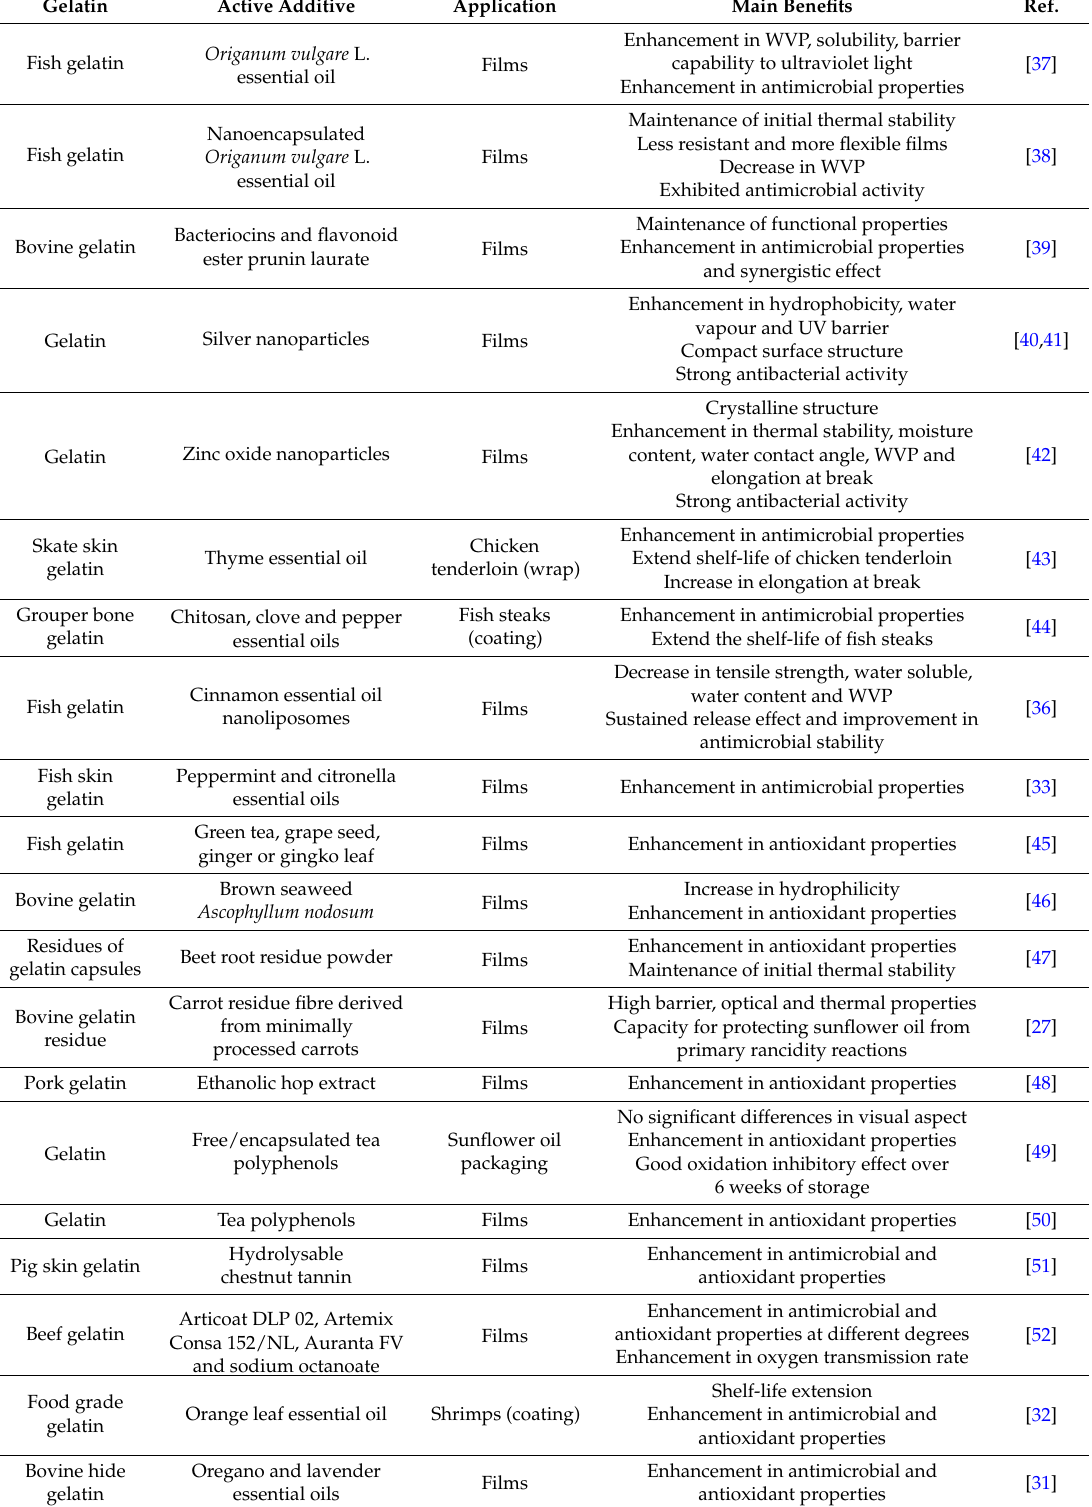
Table 1. Different compounds used as active additives in gelatin-based films and